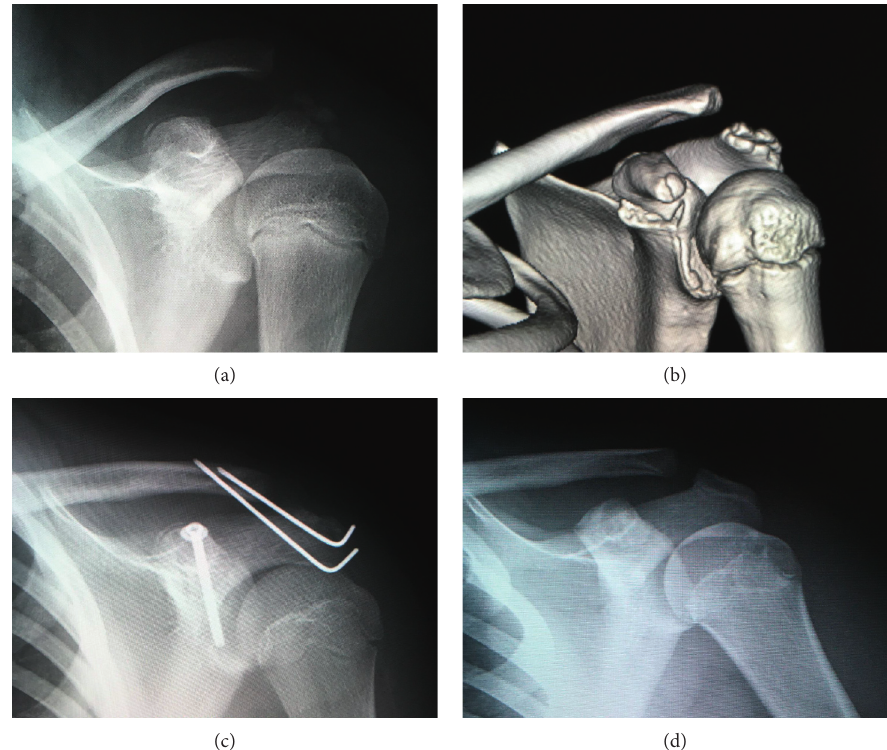
Figure 2: Case 6: representative anteroposterior radiograph: (a) three-dimensional computed tomography reconstruction and (b) Type I injury with an associated acromioclavicular dislocation. Anteroposterior radiograph immediately after the surgery (c) and anteroposterior radiograph three years after the surgery